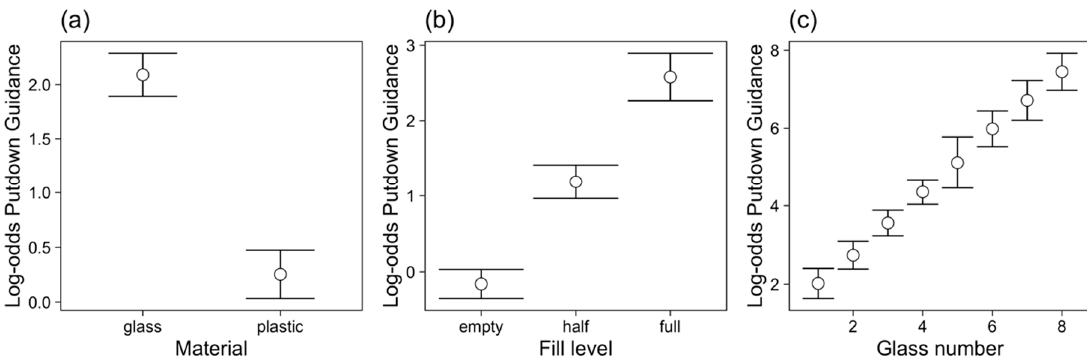
Figure 5. Log-odds of guided putdowns (in putdown 2) across participants to illustrate the effects of ( a ) material, ( b ) fill level and ( c ) glass (putdown) number with 95% confidence intervals. Individual plots for each participant are shown in Appendix Figure A3.